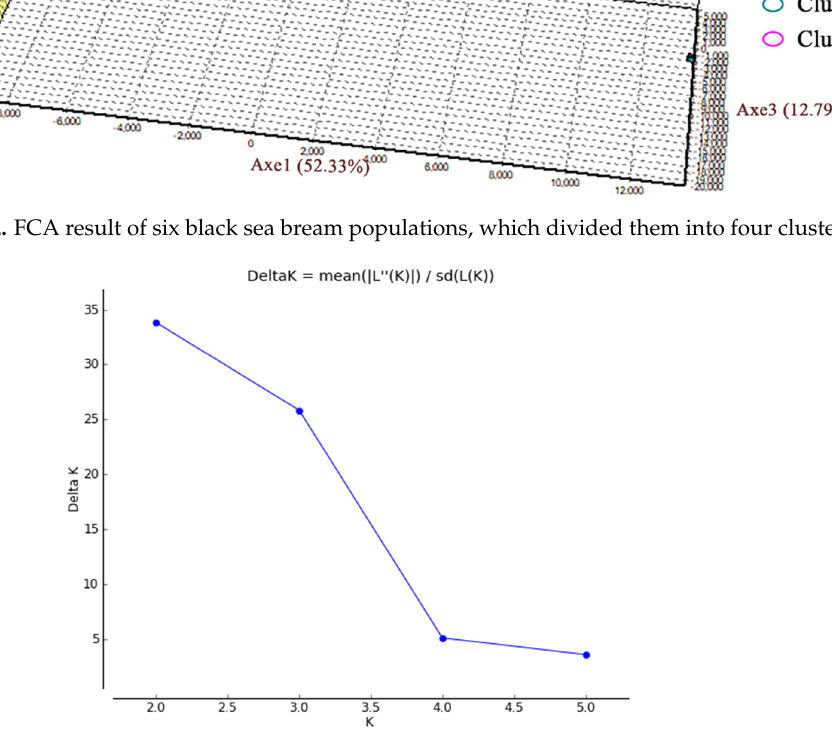
Figure 3. Result of Structure. ∆ K value at K = 2 and K = 3 were relatively higher than other K value, indicating that K = 2 or 3 were the options to divide six black sea bream populations.